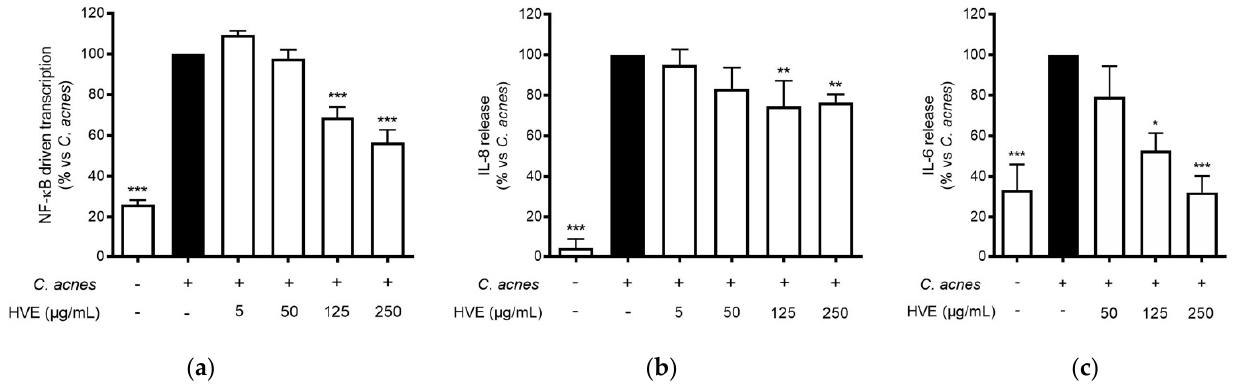
Figure 2. Effect of HVE treatment (5 –250 μg/mL) on the NF - κB -driven transcription ( a ) for 6 h, IL-8 release ( b ), and IL-6 release ( c ) in HaCaT cells infected with C. acnes (O.D. = 0.1) for 24 h. Apigenin (20 μM), representing the reference inhibitor, abrogated the NF - κB -driven transcription ( − 100%) and inhibited the release of IL-8 ( − 42%) and IL-6 ( − 97%). The amount of IL-8 in the stimulated condition was 426.41 ± 96.97 pg/mL. * p < 0.05, ** p < 0.01, *** p < 0.001 vs. stimulus.